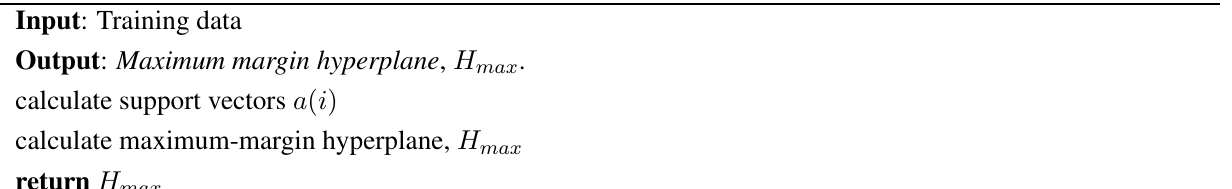
ALGORITHM 3: SVMs training